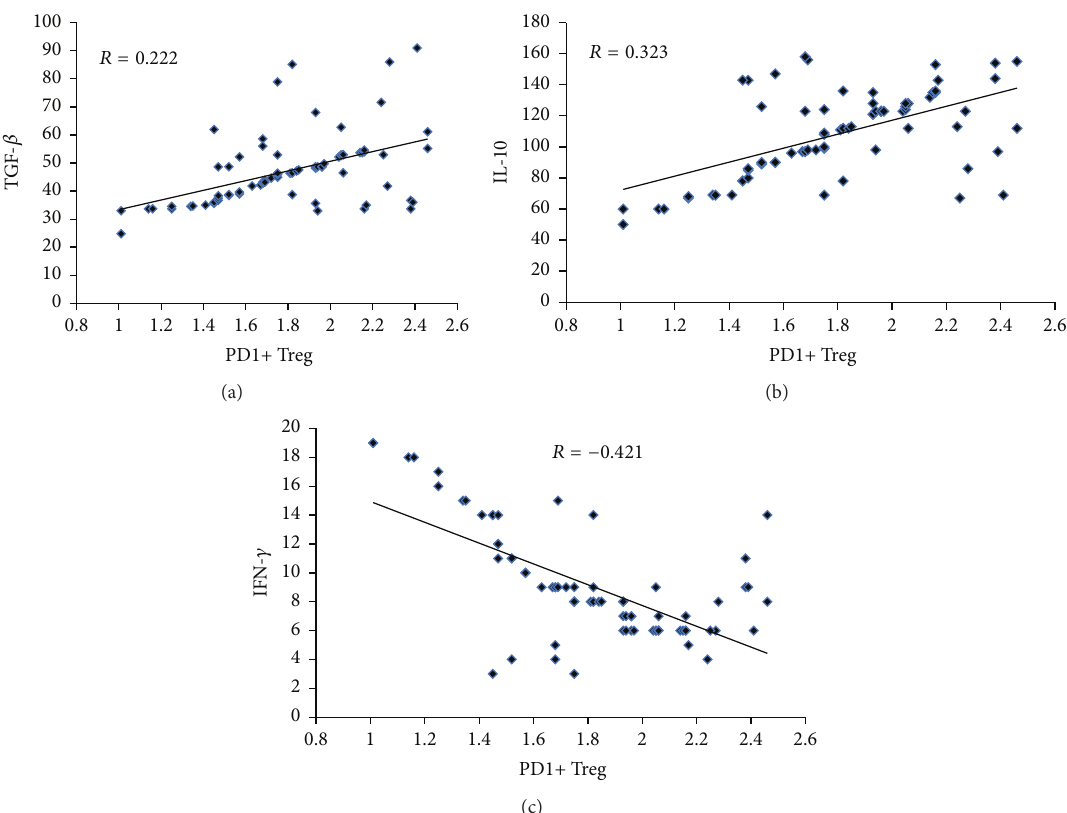
Figure 3: Correlation analyses between CD4+CD25+PD-1+Treg and (a) TGF- 𝛽 , (b) IL-10, or (c) IFN- 𝛾 . The fitted lines in (a) and (b) indicate positive correlation, while the fitted line in (c) shows negative correlation.